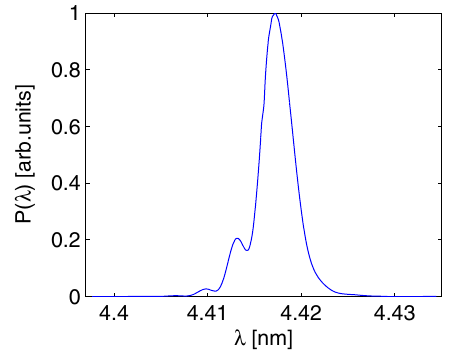
FIG. 9. The output spectrum of the